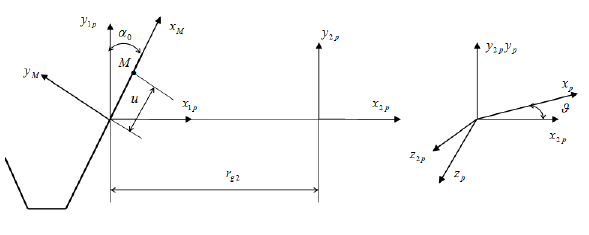
Figure 2. Cuitting head generating surface